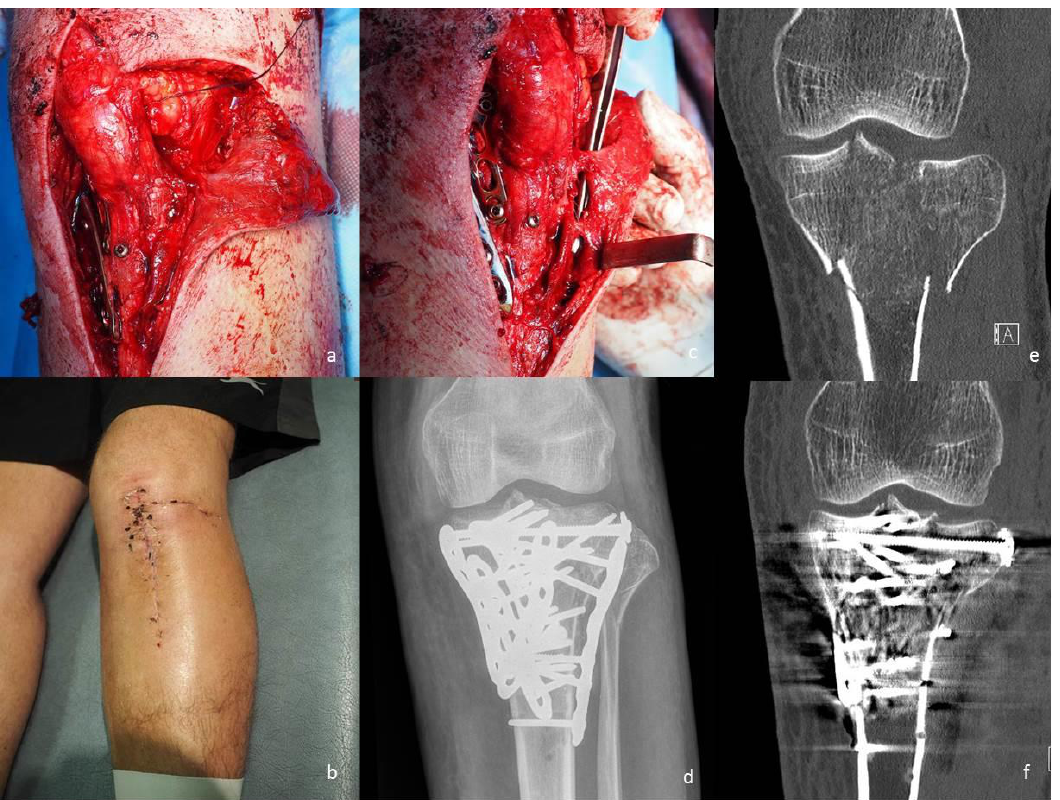
Figure 2. ( a ) The exposure used for a combined perforator-sparing anterolateral and anteromedial approach in a case treated through a combination of anterolateral, anteromedial and posteromedial approaches. ( b ) Clinical image at 2 weeks follow up, demonstrating the healed skin incisions used for